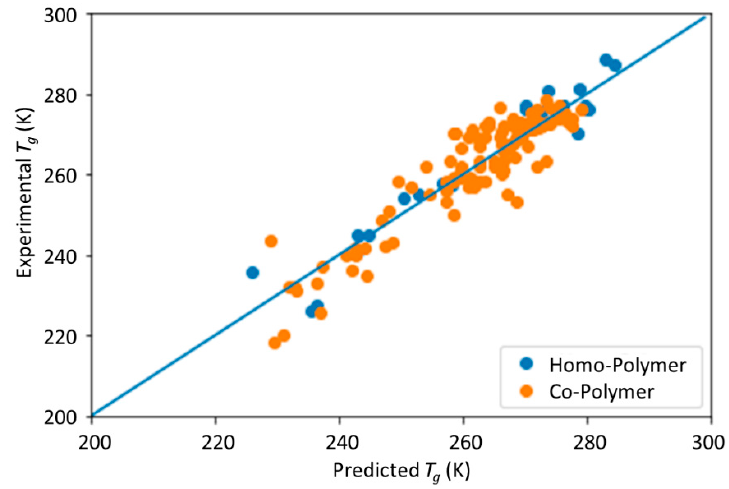
Figure 3. The scatter plot of the predicted glass transition temperature, T g by the DNN model vs. experimental measurement results, T g on the test data.